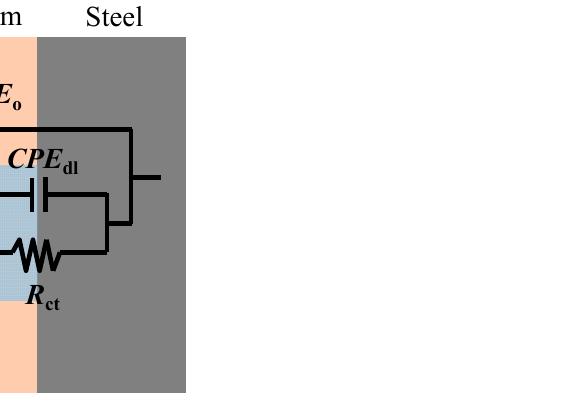
Figure 4. The equivalent circuit used to simulate the behavior of steel in the concrete pore solution.